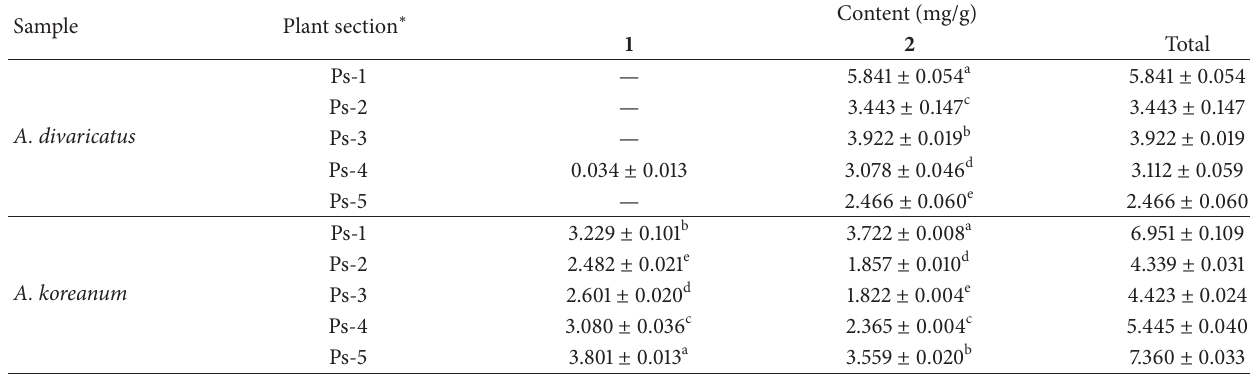
Table 1: The contents of eleutherosides B ( 1 ) and E ( 2 ) in A. divaricatus and A. koreanum divided by plant section. Sample